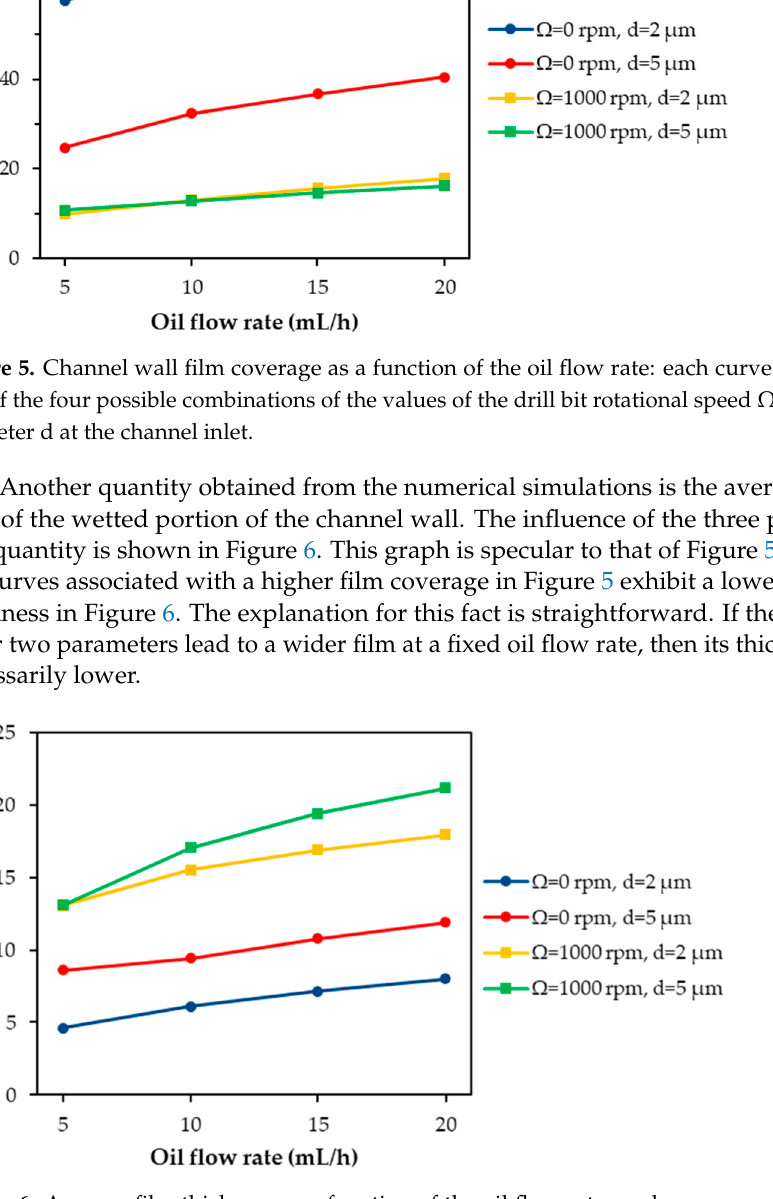
Figure 6. Average film thickness as a function of the oil flow rate: each curve corresponds to one of the four possible combinations of the values of the drill bit rotational speed Ω and oil droplet diameter d at the channel inlet.